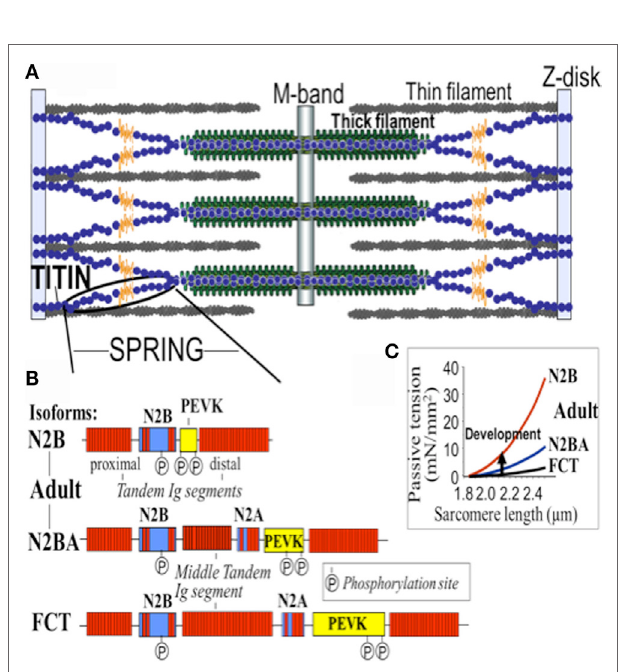
FiGURe 2 | Domain structure of titin isoforms . (A) The spring segment, (B) difference in the domain structure of different isoforms, and (C) the relationship of the passive tension with the sarcomere length in the different isoforms. FTC, fetal cardiac